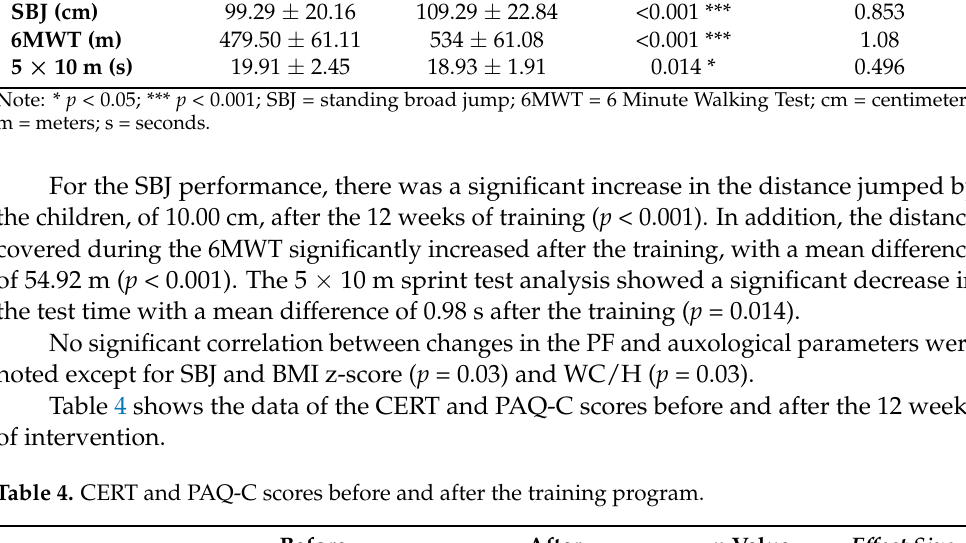
Table 3. Physical fitness test results before and after the training program. Before After p -Value Effect Size